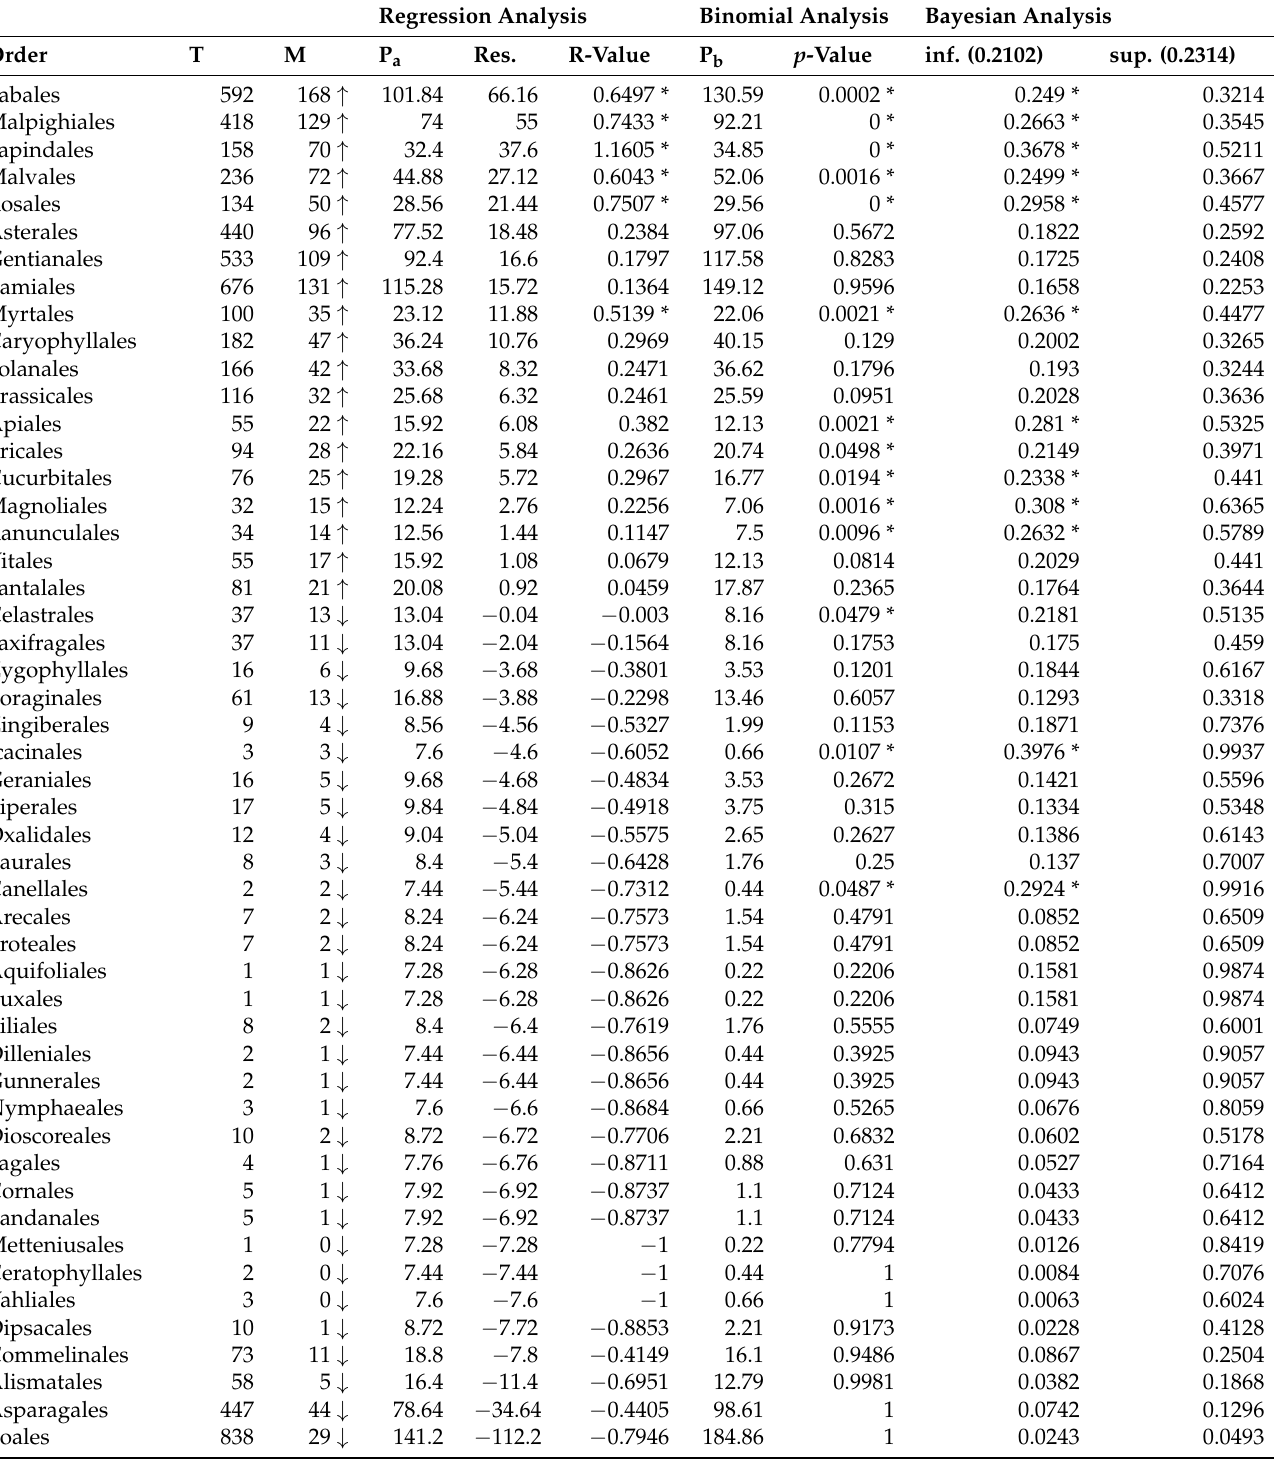
Table 1. Quantitative analysis of medicinal species in orders. T—total number of species in the flora; M—medicinal species; ↑ / ↓ —positive/negative outliers based on residuals; P a —predicted medicinal species under regression model; Res.—regression residuals; P b —predicted medicinal species under binomial model; inf.—Bayesian inferior 95% probability credible intervals; sup.—Bayesian superior 95% probability credible intervals; *—positive